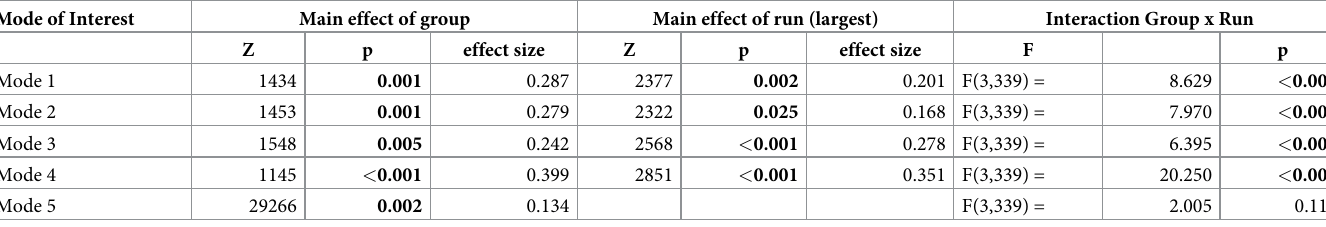
Bold font indicates statistical